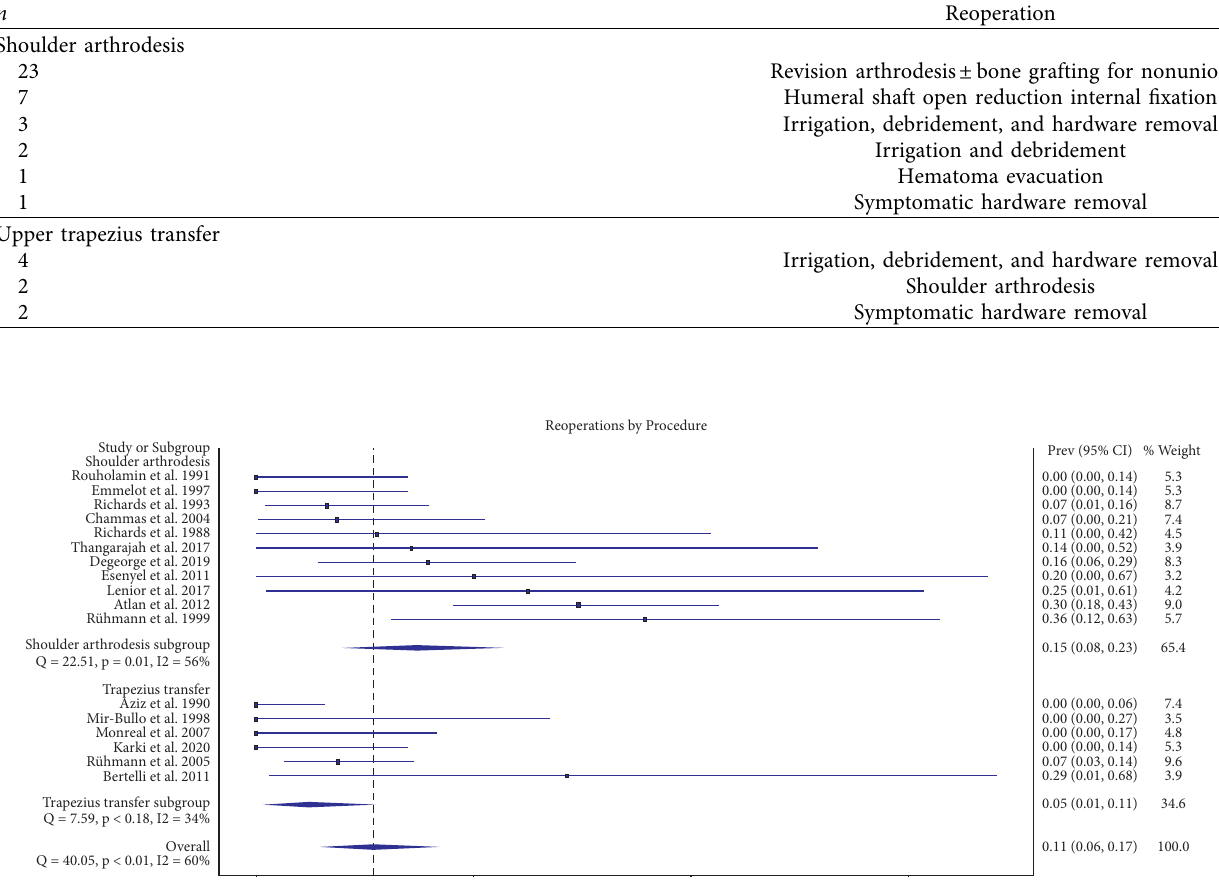
= 22.51, p = 0.01, I2 = 56%